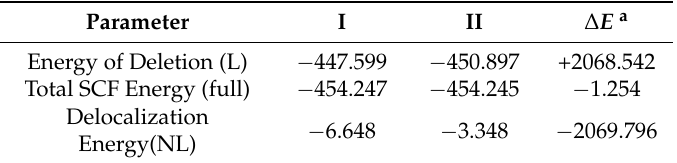
Table 8. NBO analyses of the total SCF, deletion and delocalization energies (a.u.) for hydrogen bonded imidazole-4-acetic acid (I) and imidazole-5-acetic acid (II) which were calculated by using B3LYP functional with 6-311++G** basis